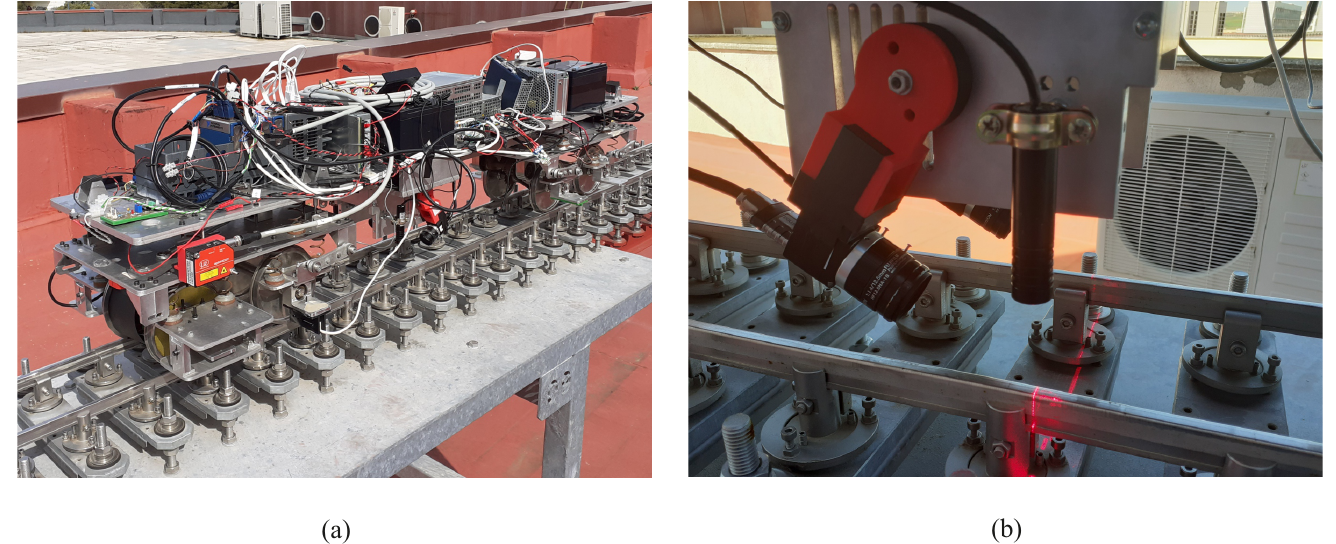
Figure 14. Scale vehicle, ( a ) global view of instrumented scale vehicle, ( b ) detail showing video cameras and laser beam.